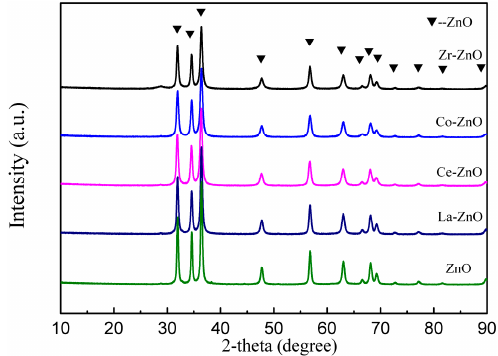
Figure 3. XRD patterns of ZnO catalyst modified by transition metal.